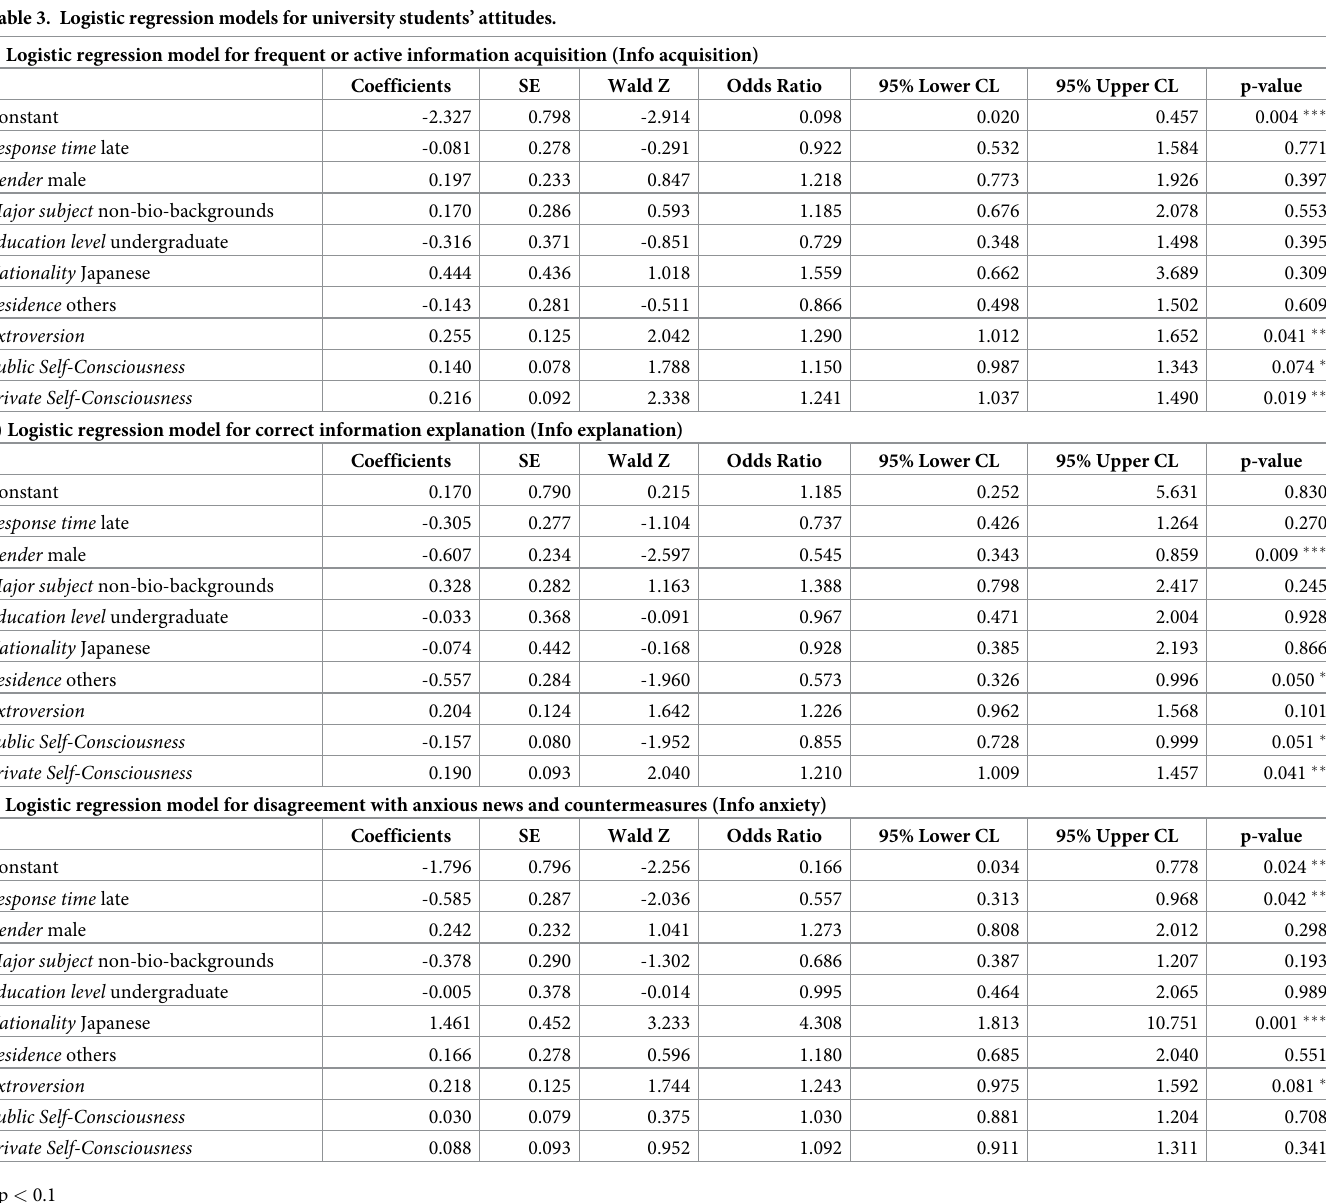
Table 3. Logistic regression models for university students’